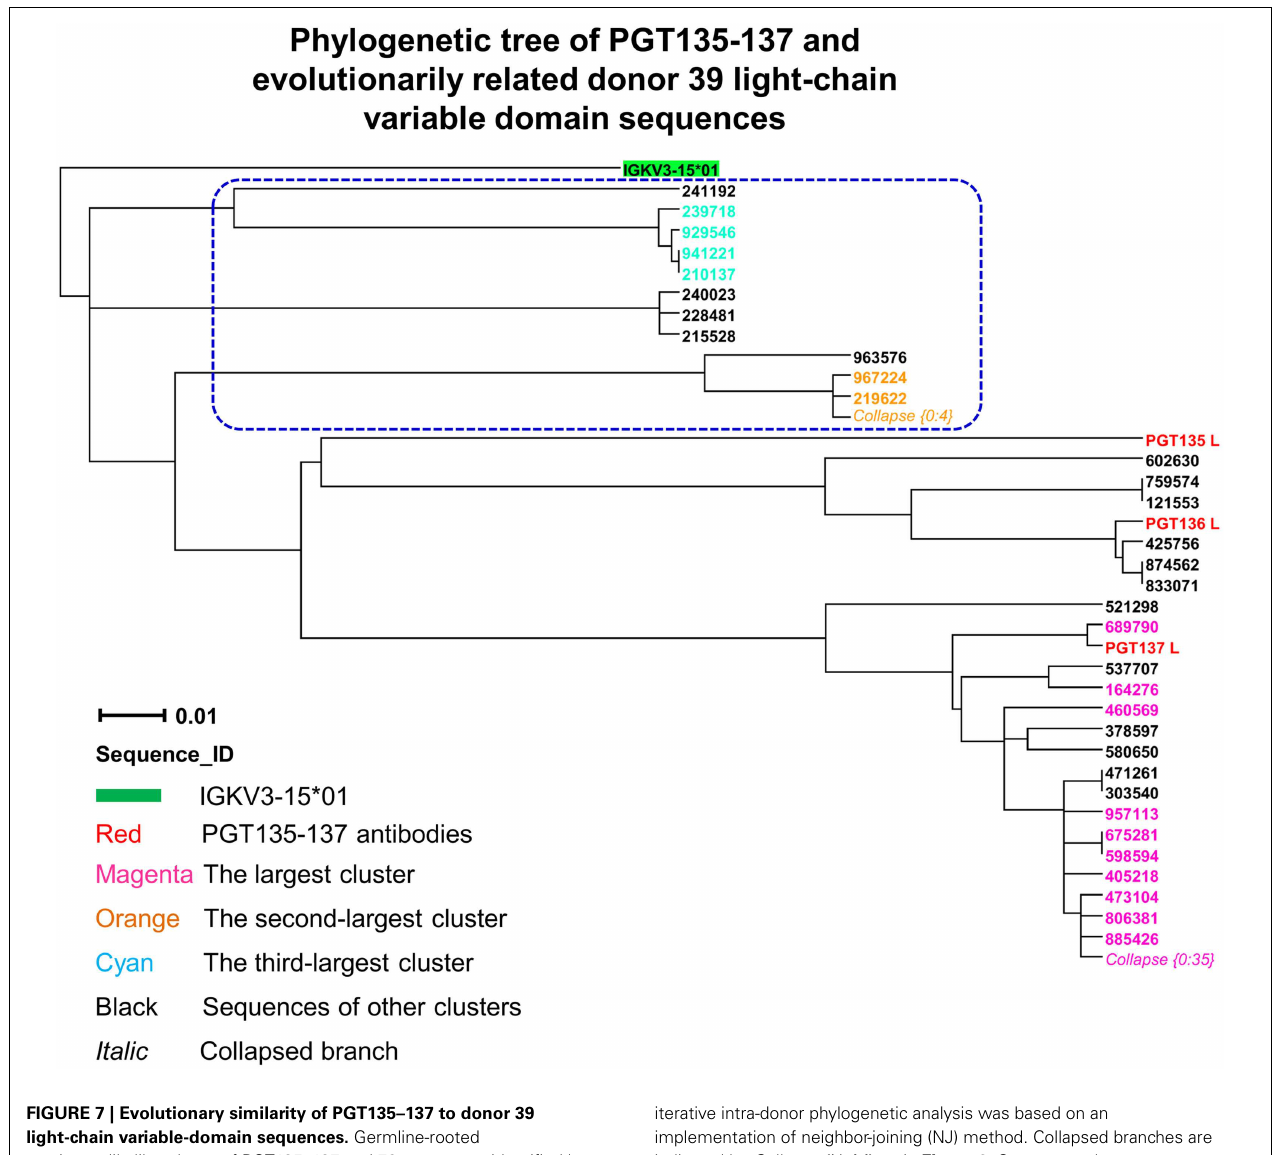
FIGURE 7 | Evolutionary similarity of PGT135–137 to donor 39 light-chain variable-domain sequences. Germline-rooted maximum-likelihood tree of PGT135–137 and 72 sequences identified by the iterative intra-donor phylogenetic analysis of donor 39 light-chain variable-domain sequences determined by 454 pyrosequencing.The